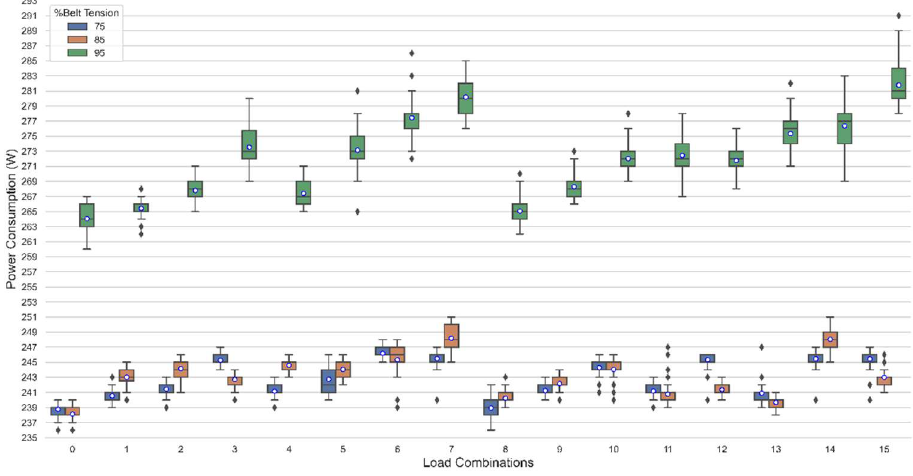
0.279 Table 8. Dynamic case results for 95% belt tension with active zones. Belt Tension (%) Act. Zone Src. Zone Dst. Zone Distance (m) Time (s) Speed (m/s) 95